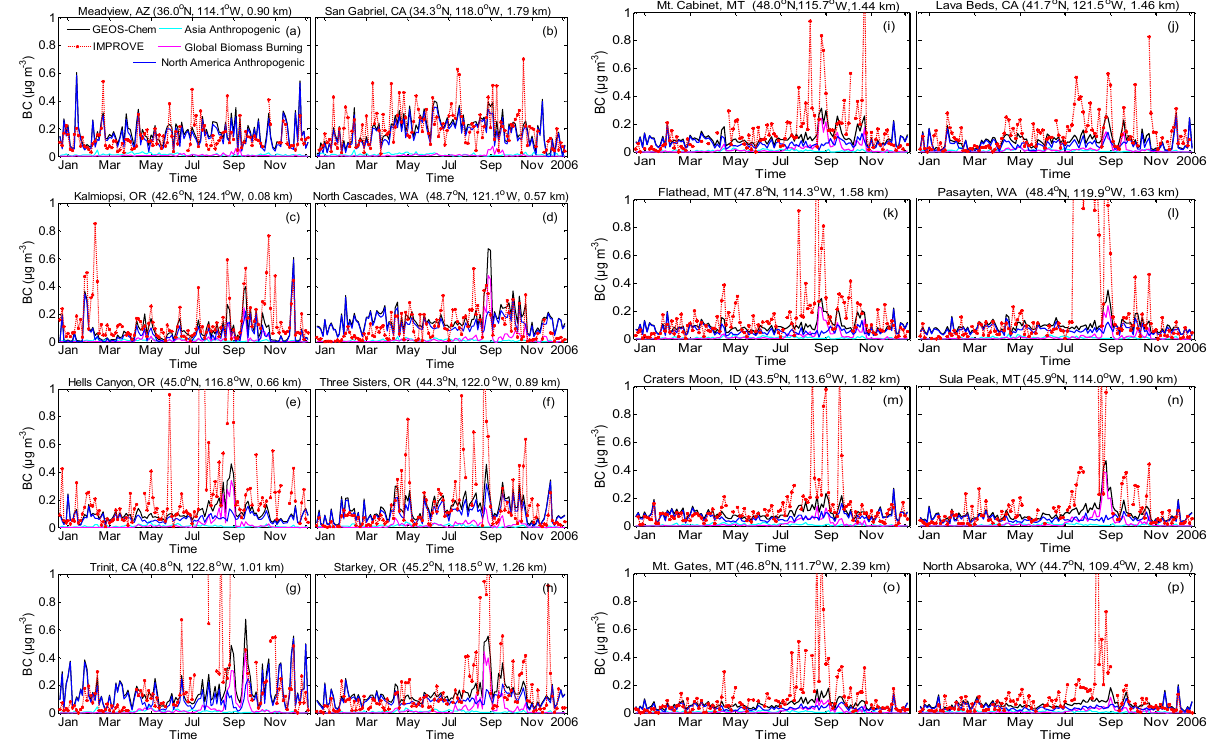
Figure 3. continued. Fig. 3. (a-p) Simulated (black line) and observed (red line) daily surface BC concentrations at representative IMPROVE sites (Fig. 1) in 2006. Values shown are daily averages for every three days. Simulations are driven by GEOS-4 reanalysis data and with GFEDv2 8-day emissions. Model results are sampled at the time and location of IMPROVE observations. Also shown are relative contributions to surface BC concentrations from Asian anthropogenic emissions (green line), global biomass burning emissions (pink line), and North American anthropogenic emissions (blue